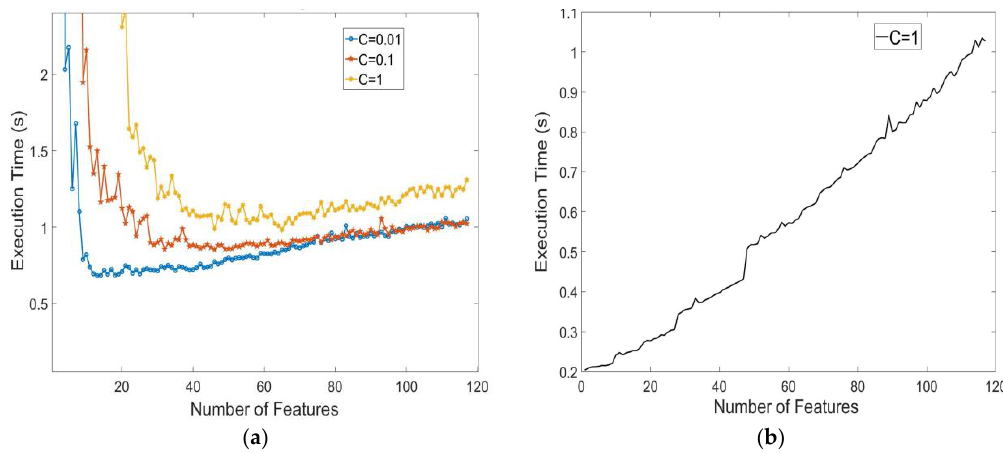
Figure 12. Execution time evolution with increasing number of features for the Sentinel-2 quadratic SVM crop type classification, showing in ( a ) the training time for three different C values and in ( b ) the implementation time for C = 1.